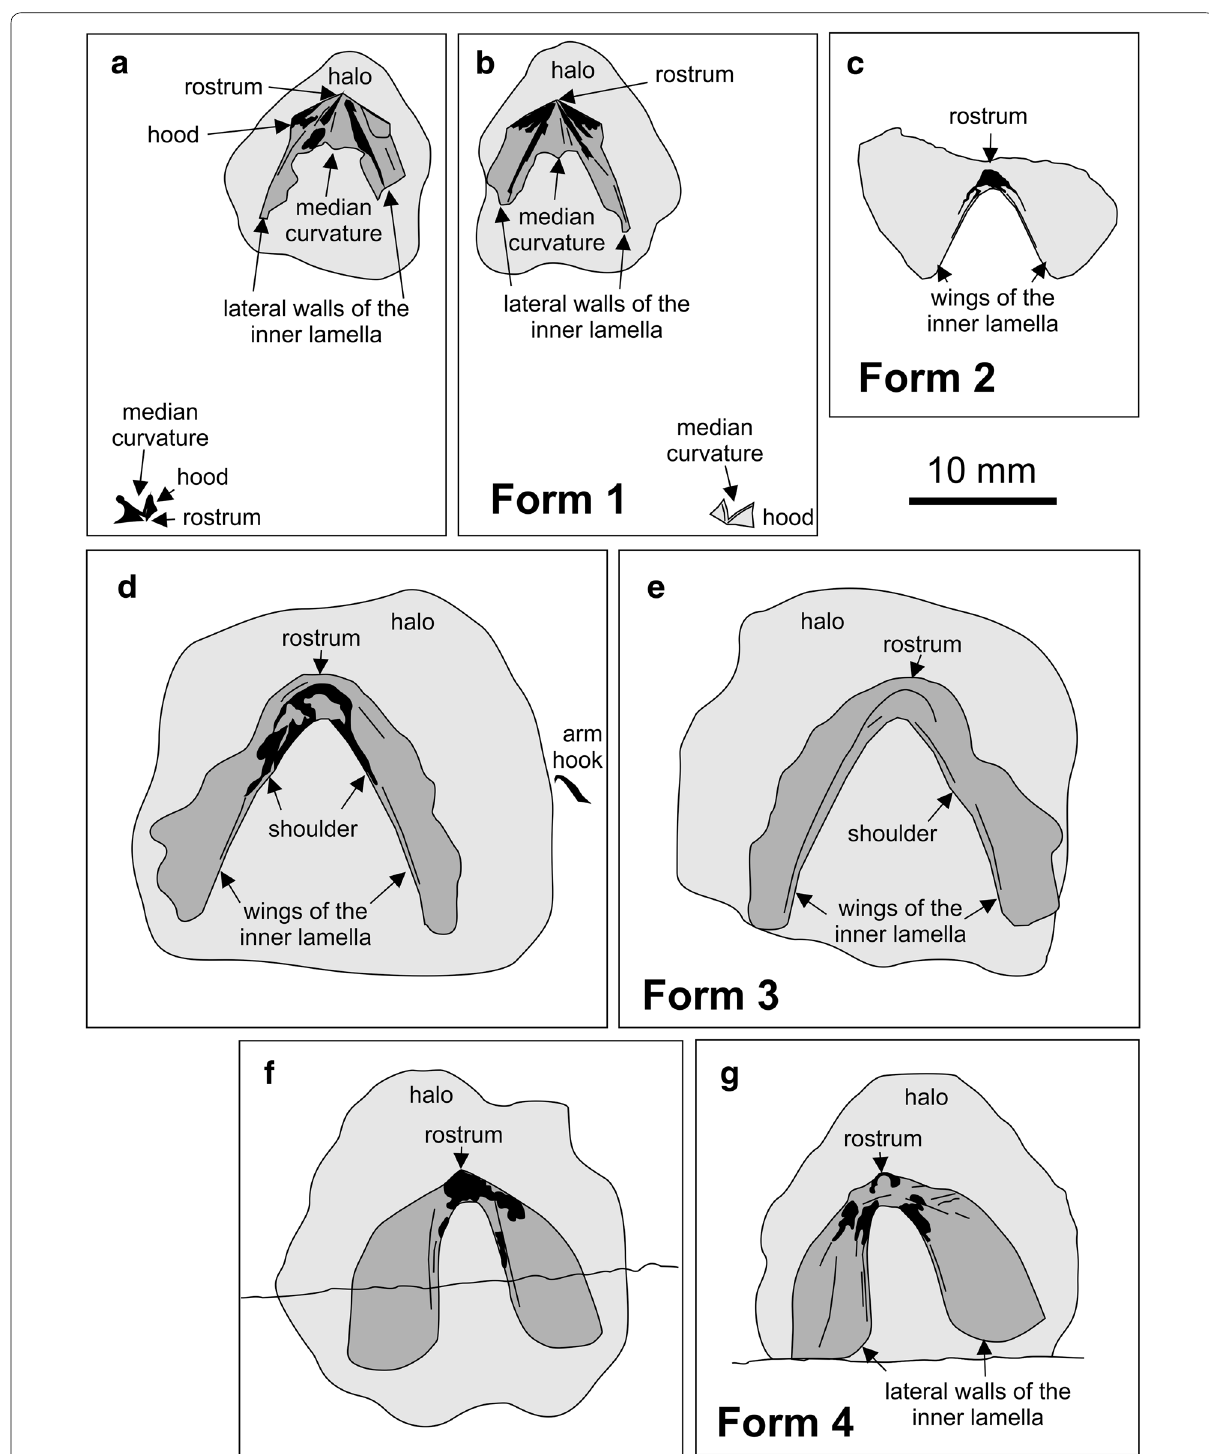
Fig. 3 Some cephalopod jaws from the Maastrichtian of continental Greece. Note the halos (light grey) around all specimens. Black areas indicate the presence of sclerotized sheets. Middle grey areas indicate surfaces where the dark coating was very thin or broke off. a , b Slab and counterslab showing the apatitic remains of ammonitin upper jaws; SGL1_4b,a. c Lower jaw of a cephalopod, maybe an ammonite anaptychus, remotely resembling the lower jaw of Vampyroteuthis ; SGL1_34. d , e Lower jaw of a teudopsein coleoid; SGL1_22a,b. f , g Lower jaw of a teudopsein